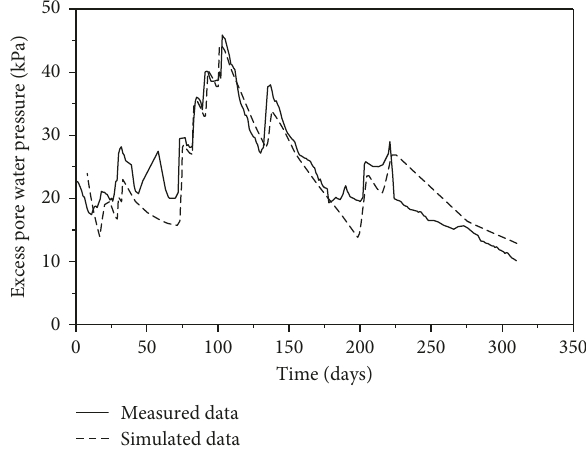
Figure 6: Pore water pressure obtained by field measurement and